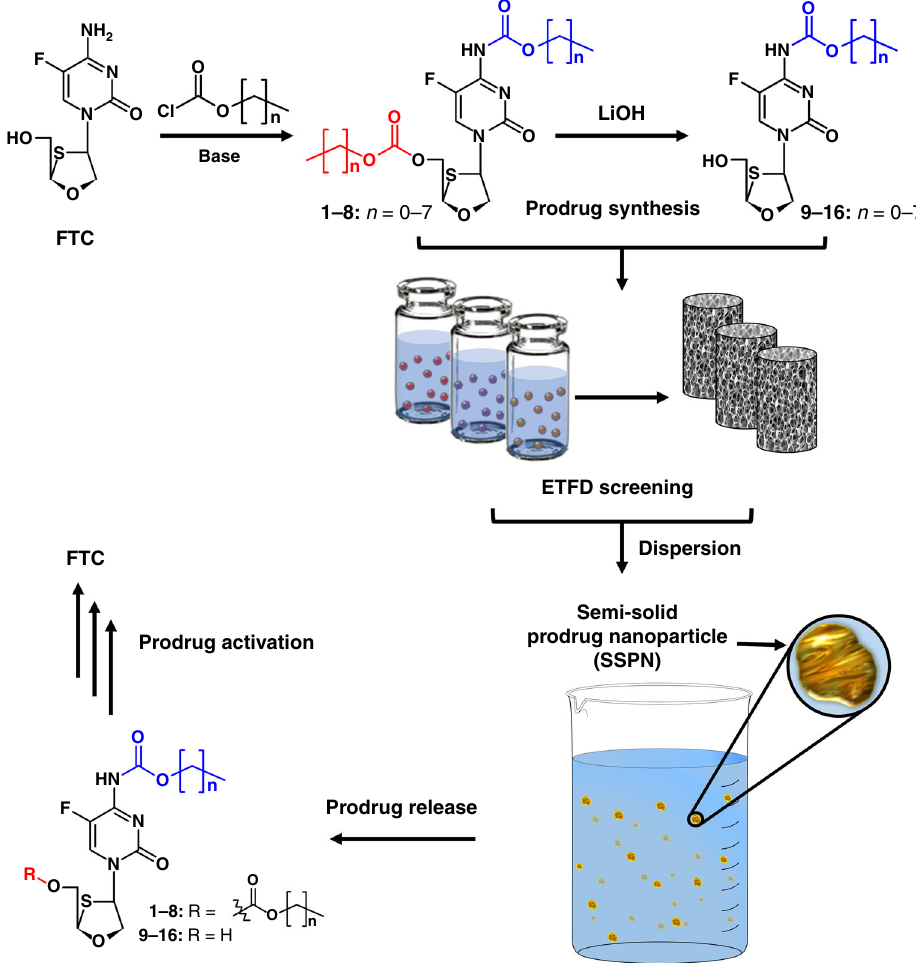
Fig. 1 Schematic overview of long-acting semi-solid prodrug nanoparticle (SSPN) strategy. Emulsion-templated freeze drying (ETFD) screening is applied to a range of emtrictabine (FTC) prodrugs bearing bio-reversible carbonate and carbamate masking groups. SSPNs are released into aqueous media after rapid dispersion of ETFD monoliths into water, resulting in a dispersion of SSPNs slowly releasing prodrug under physiologically relevant conditions and subsequent bioactivation to release the parent